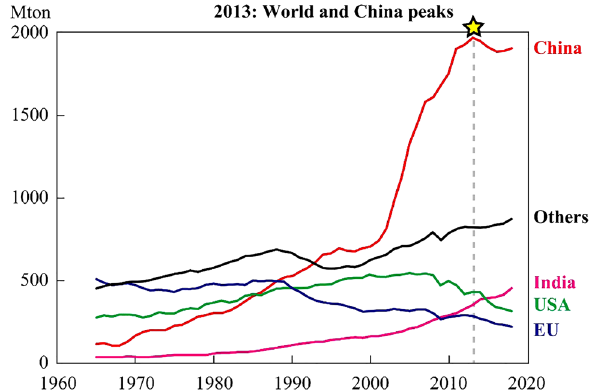
Figure 5. Global coal consumption. Graph showing peaks of world and China coal consumption, which occurred in 2013 (year of sampling survey of current study). Data source: 18